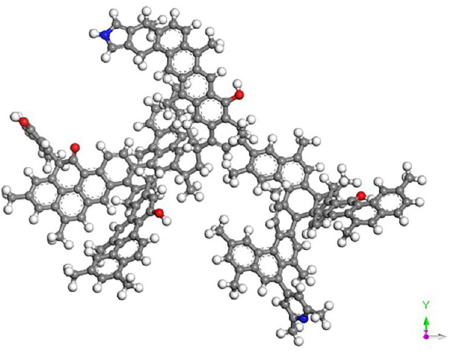
Figure 2. Stable configuration of the molecular structure of coal after geometric optimization.